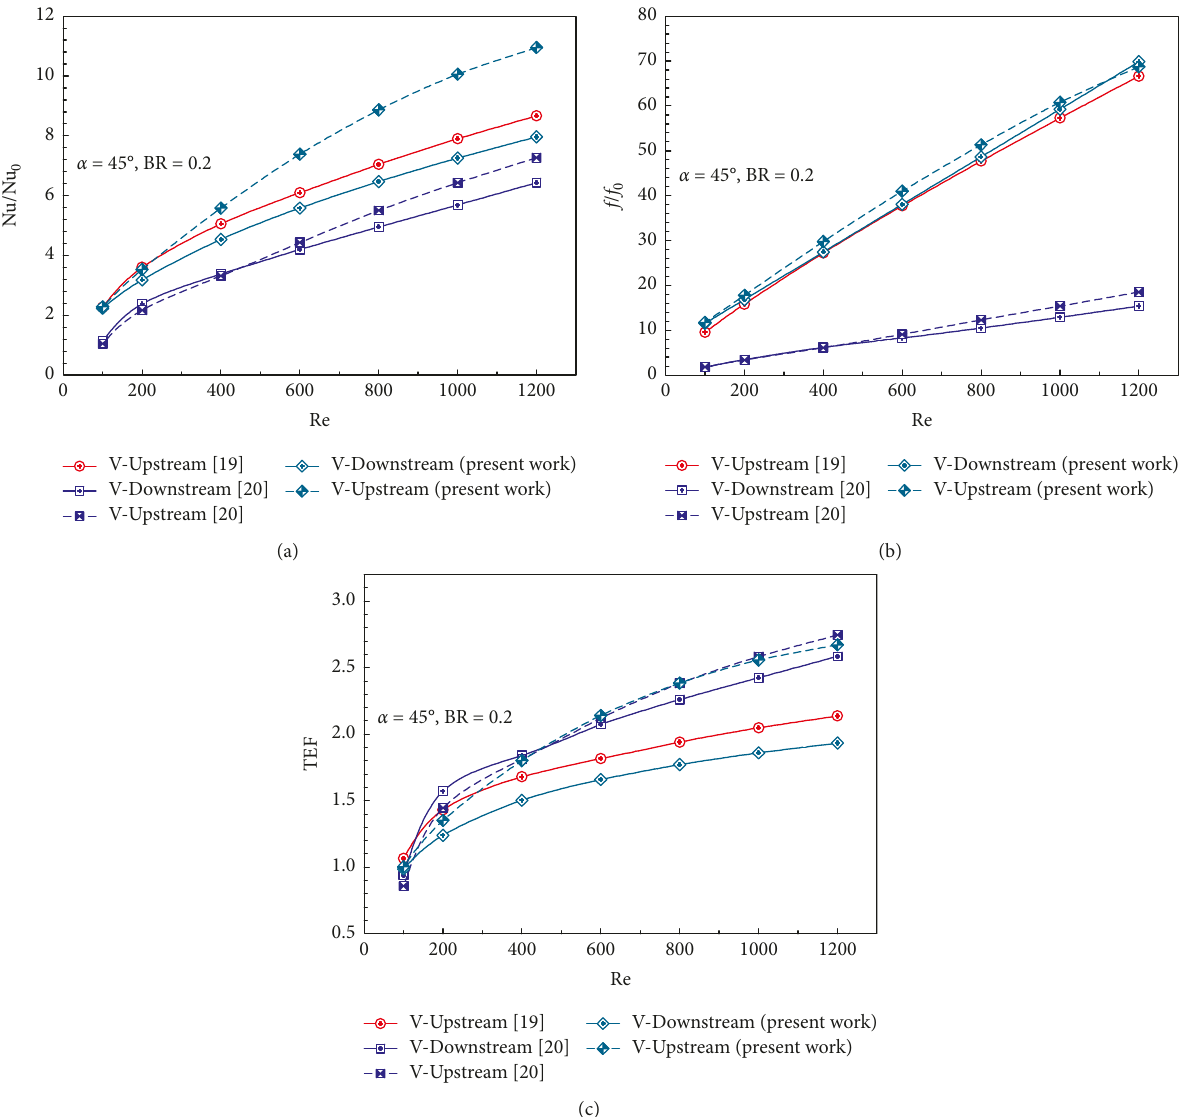
Figure 27: Comparison with the previous works for (a) Nu/Nu